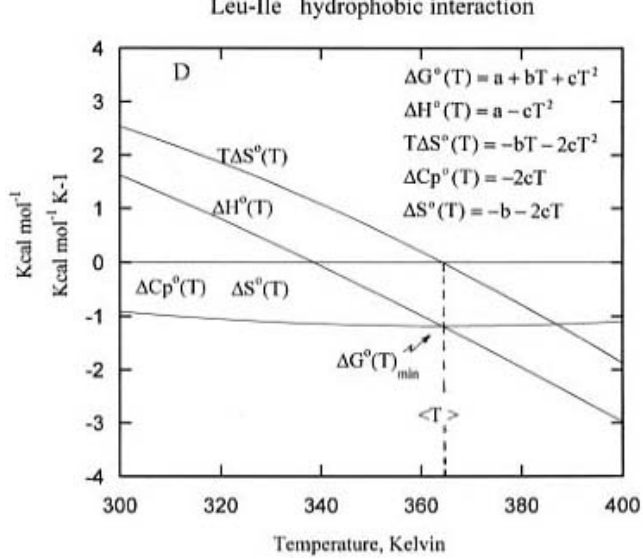
FIGURE 3D. A close-up view of a portion of Leu-Ile hydrophobic interaction as shown in Fig. 3B, over the temperature range of 300–400 K, with the magnitude of the y-axis reduced to 4 to –4 kcal mol -1 K -1 .